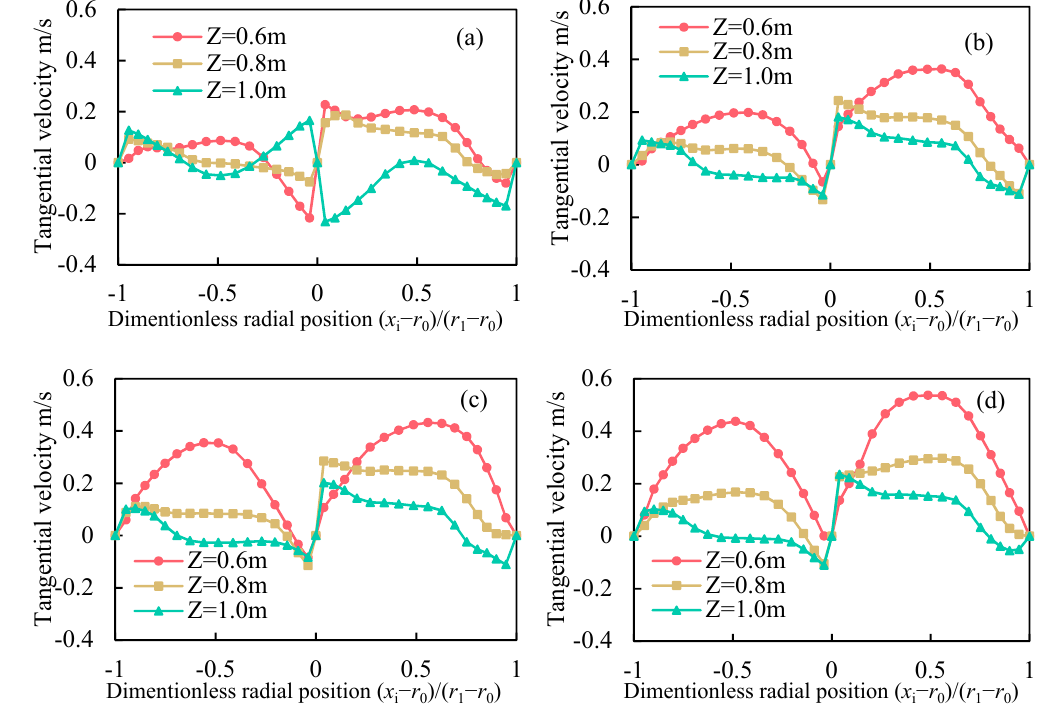
Figure 4. The tangential velocity of particles at different cross section: ( a ) 100 rpm; ( b ) 200 rpm; ( c ) 300 rpm; ( d ) 400 rpm.